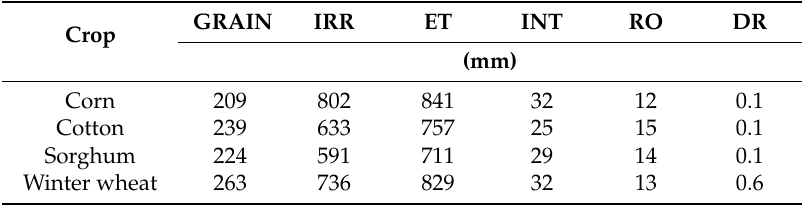
Table 3. Summary of major water budget components for the baseline